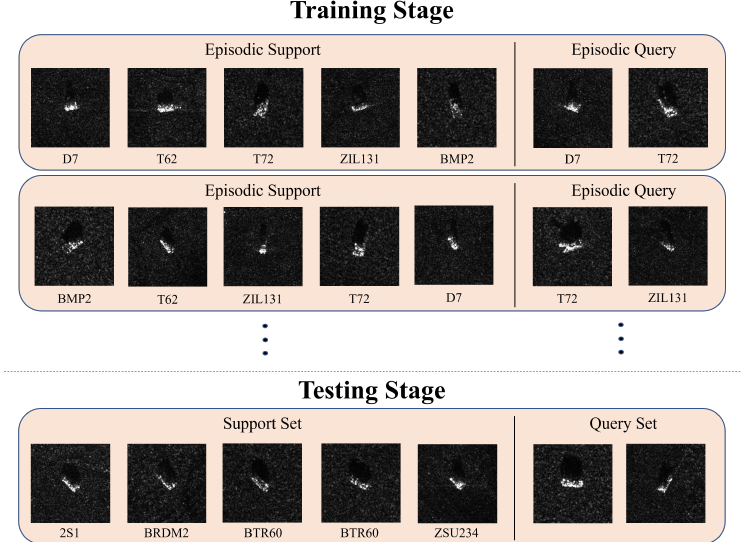
Figure 2. Episodic training and testing of few-shot classification. The code below each plot indicates its category, which can be found in Section